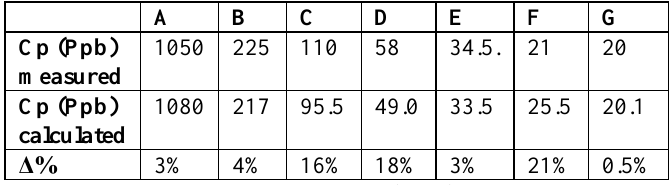
Table 3: Comparison of measured vs calculated values of Cp(t) in each